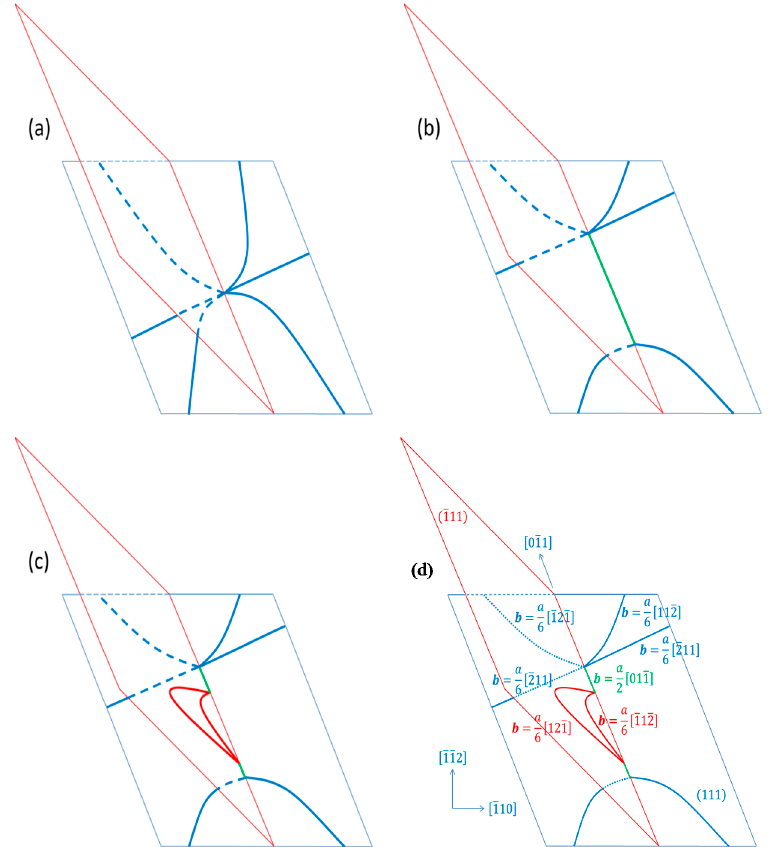
Figure 5. Geometry of dislocation nucleation at a low angle twist boundary. ( a ) Initial geometry at the intersection node of intrinsic GB dislocation. The lattice slip plane shown in red; ( b ) under the load, the network deforms, the node splits, and new dislocation is created (green) which can glide in the lattice slip plane; ( c ) two half loops of partials, separated by the stacking fault expand into the crystal; and ( d ) quantitative details of the geometry: Burgers vectors, planes, and directions.